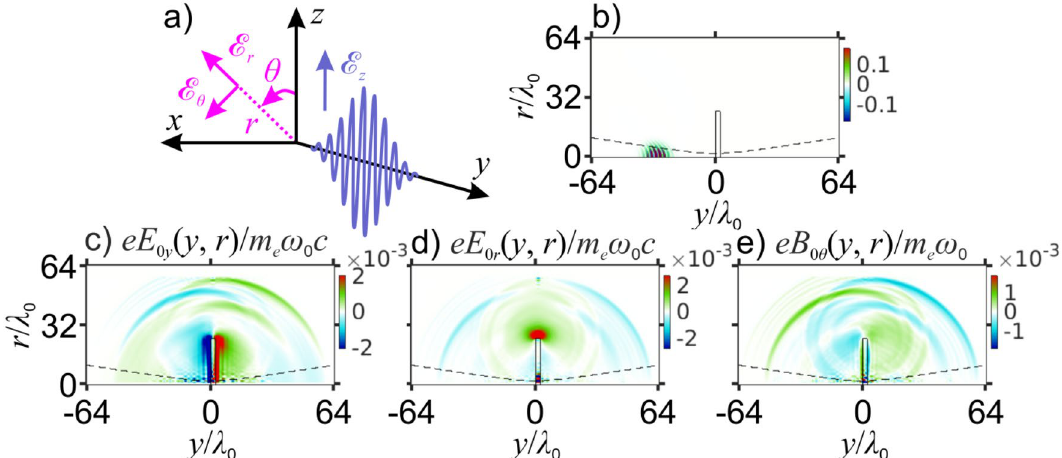
Figure 6. ( a ) The driving laser field (blue line) and its components against the Cartesian (black) and cylindrical coordinates (pink) used in 3D PIC simulations. ( b ) An ry -map of the laser field approaching the plasma target. ( c – e ) Spatial distributions of the E 0 y ( y , r ) ( c ), E 0 r ( y , r ) ( d ), and B 0 θ ( y , r ) ( e ) components of the THz field for t = 90 T 0 and a 0 = 1. The dashed line is the FWHM radius of the driver laser beam propagating in space with no plasmas. Also shown is laser-driven electric charge separation in shielding plasma currents (red and blue coding is for the positive and negative charges, respectively), giving rise to antenna-like emission of THz radiation from plasma